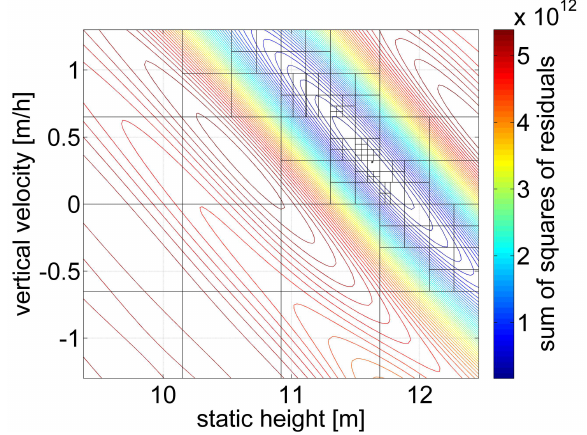
Figure 10: Contour plot of the cost functions with the investigated intervals